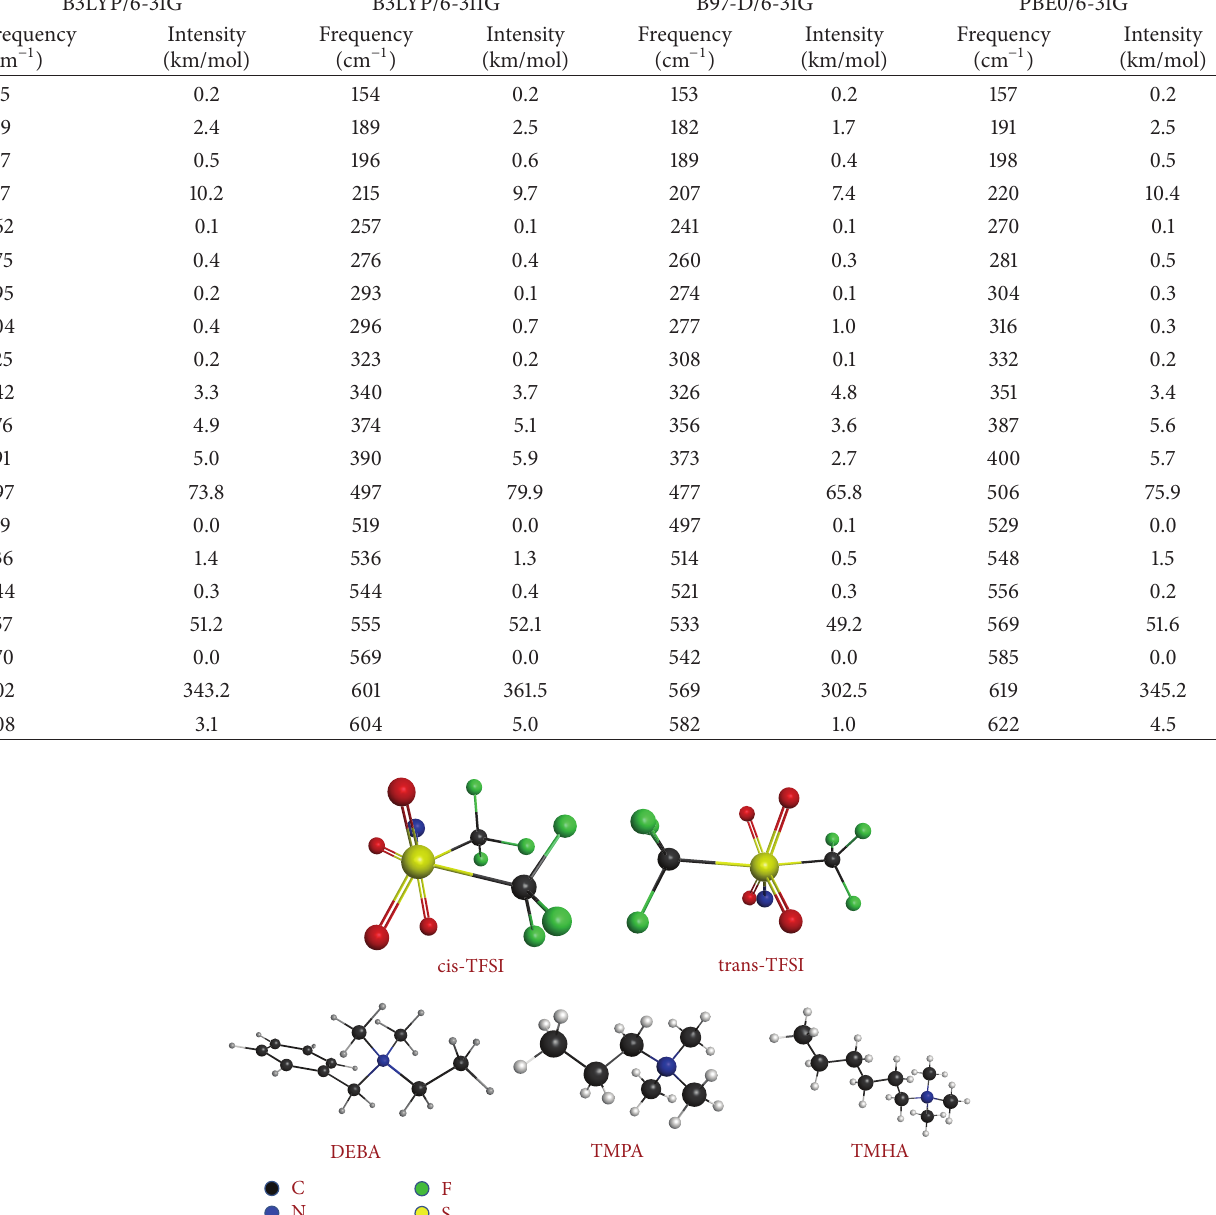
Table 1: Unscaled calculated frequency and intensity of the vibrations of trans-TFSI in the frequency range between 150 and 670 cm −1 , with various levels of theory and basis sets.